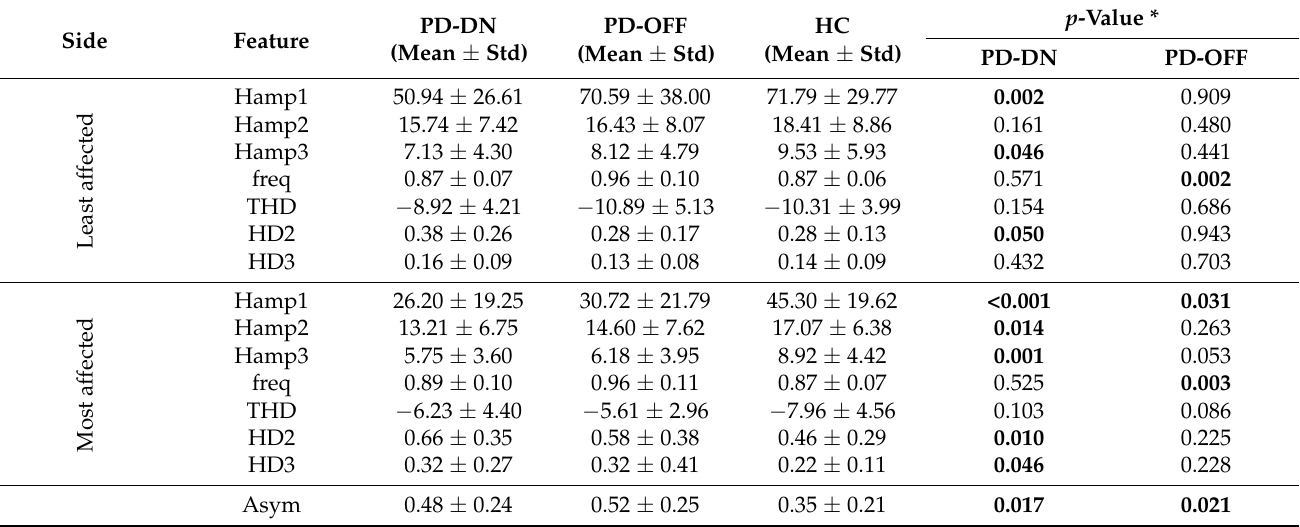
Table 3. Values of the motor features related to PD-DN, PD-OFF and HC.